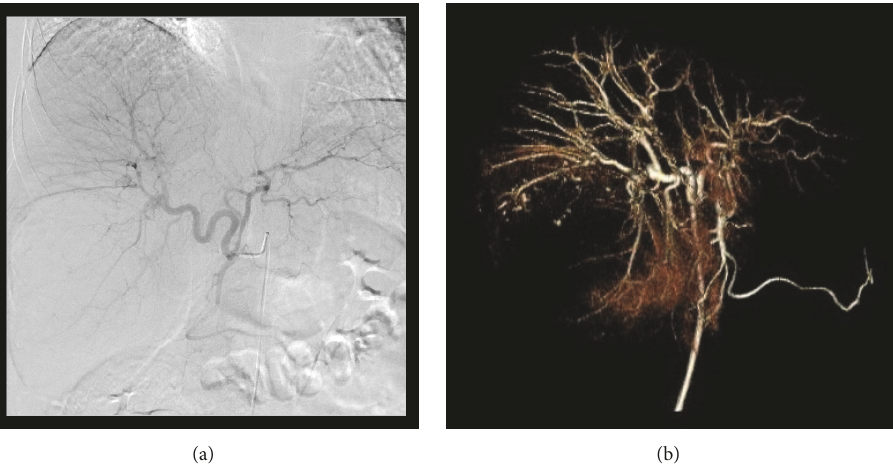
Figure 2: Abdominal angiography. (a) Common hepatic angiography image. (b) Three-dimensional image obtained by common hepatic angiography. Hepatic angiography shows a large avascular region in the liver corresponding to the tumor.